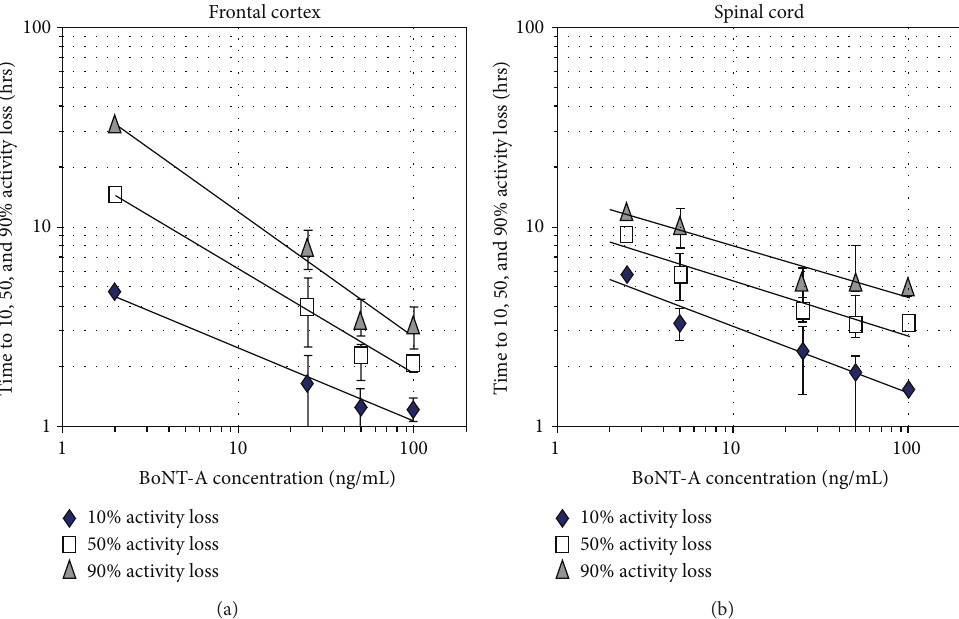
Figure 5: Quantification of frontal cortex (a) and spinal cord (b) network responses to BoNT-A concentrations ( 𝑥 -axis; ng/mL). The time required to reach 10, 50, and 90 percent activity decreases is displayed on the 𝑦 -axis. Both tissues generate approximate linear power function trend lines over the concentration range from 2 to 100ng/mL (data points represent mean ± standard deviation).